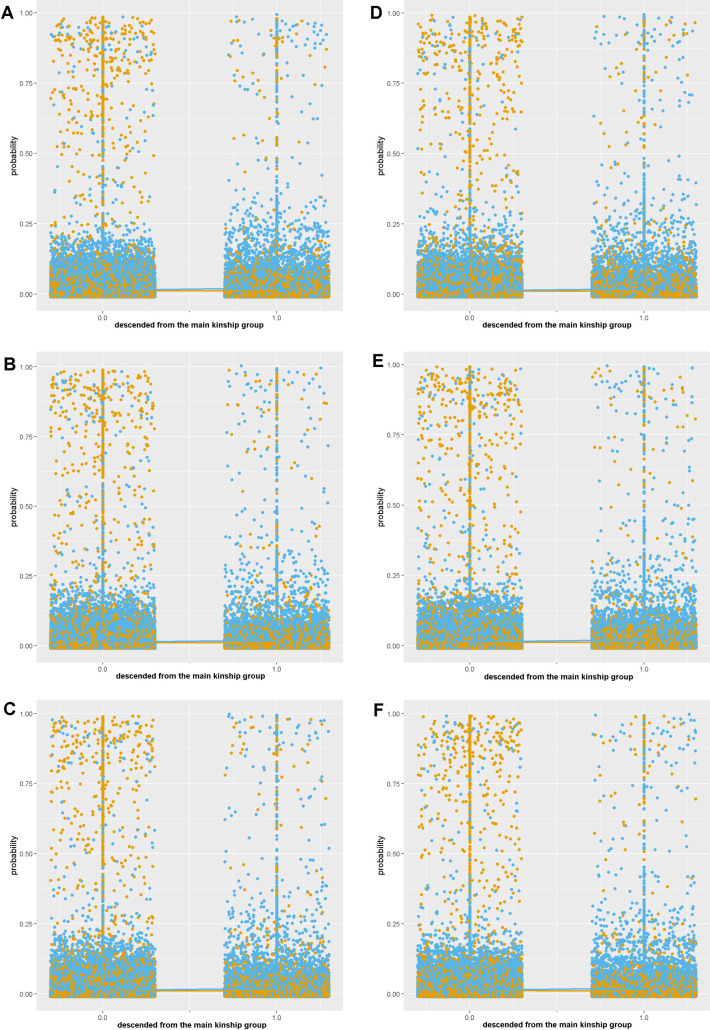
Probability of an edge forming between each possible pairing of the 303 people in the network who are (1.0) or are not (0.0) both from the main kinship group.Dots representing the probability of each possible edge calculated from exponential random graph models are orange for man-woman pairs and blue for same-gender pairs. Key: A = M2, B = M3, C = M4, D = M5, E = M6, F = M7.